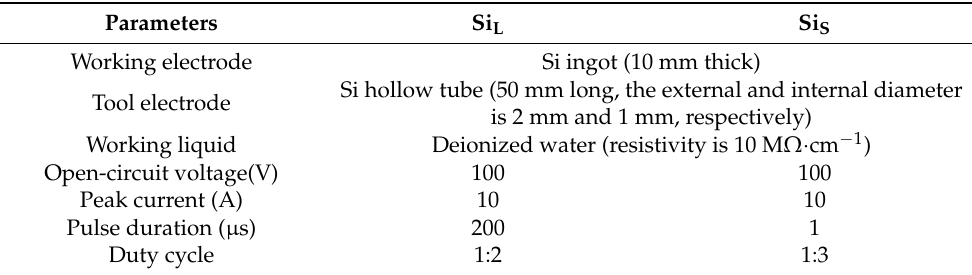
Table 1. The specific parameters of spark